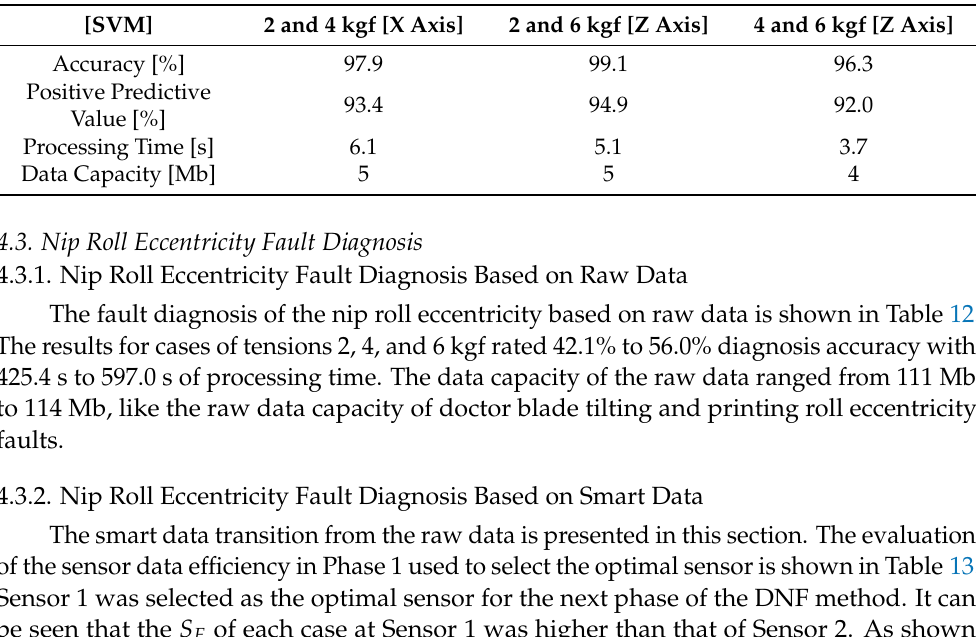
Figure 7. Volume comparison of normal and abnormal condition data: ( a ) Operating tensions of 2 and 4 kgf; ( b ) Operating tensions of 2 and 6 kgf; and ( c ) Operating tensions of 4 and 6 kgf. Table 11. Printing roll eccentricity fault diagnosis based on smart data.